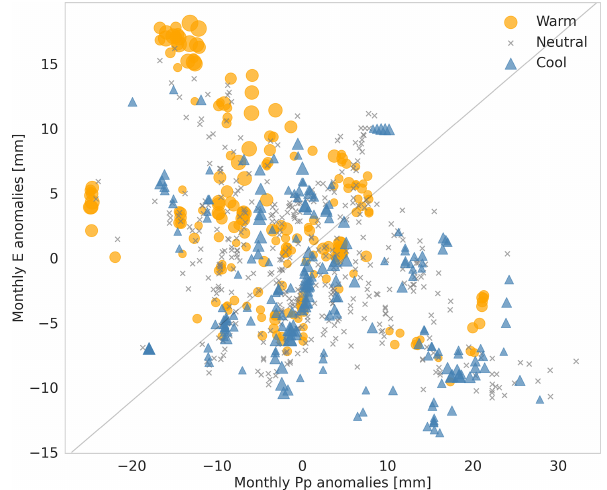
Figure 13. Relationship between monthly evaporation (E) and monthly precipitation (Pp) anomalies between 1950 and 2020. The anomalies are classified into warm, neutral and cool ENSO phases. The symbol size reflects the ONI intensity, where ONI ≥ 1 corre- sponds to an intense warm phase (circle) and ONI ≤ − 1 to an in- tense cool phase